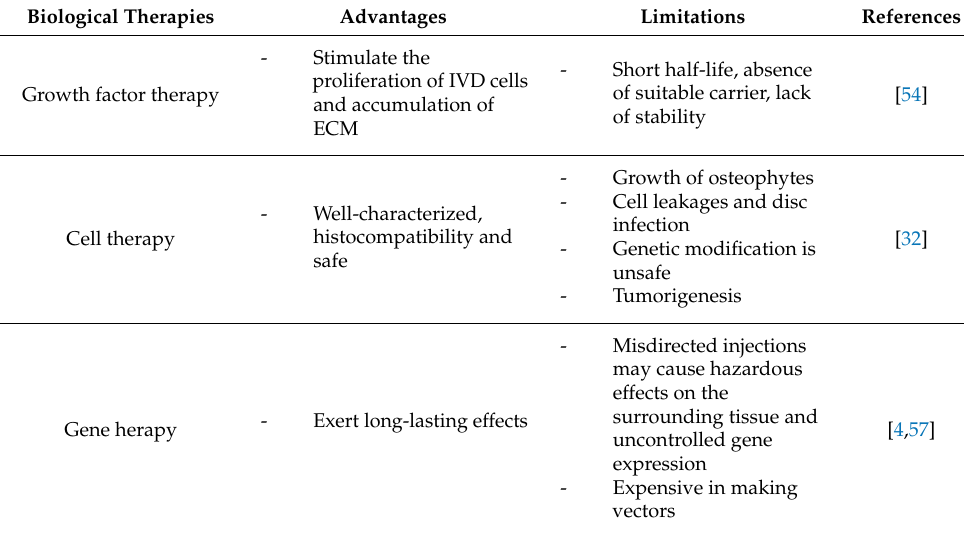
Table 2. Advantages and limitations of biological